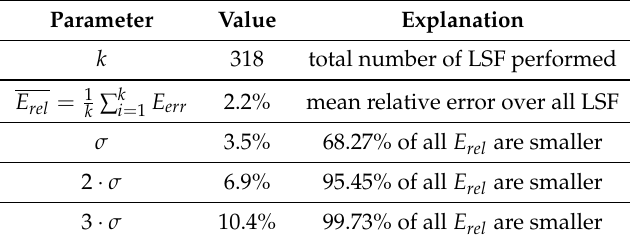
Table 4. Standard deviation of the least square procedures’ (LSF) relative error E rel for a ef f , u = a ef f , d = 1350 m s